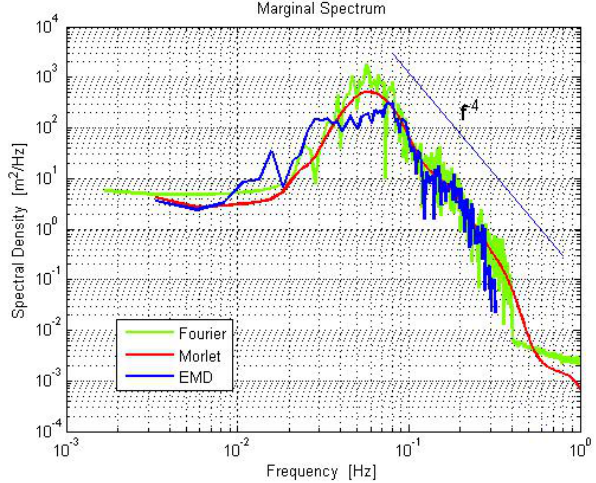
Figure 3. Spectrum analysis of the data in Figure 2. Fig. 3. Spectrum analysis of the data in Fig. 2.